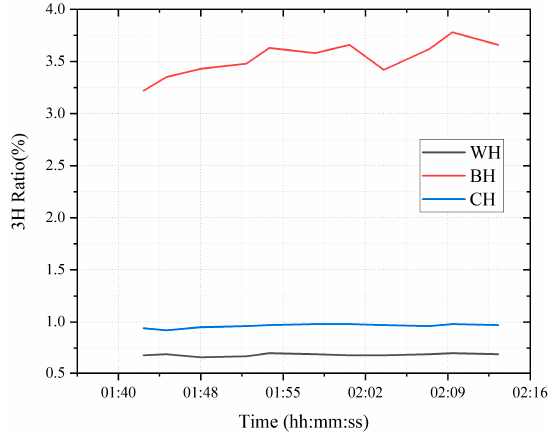
Figure 8. 3H ratio diagram of well Y.